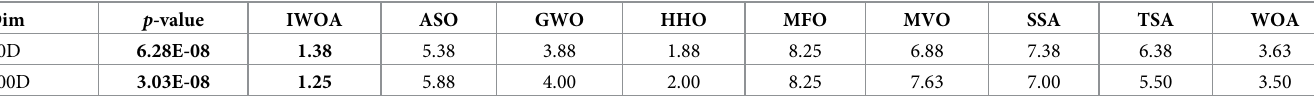
Table 6. Friedman test results of benchmark functions with different